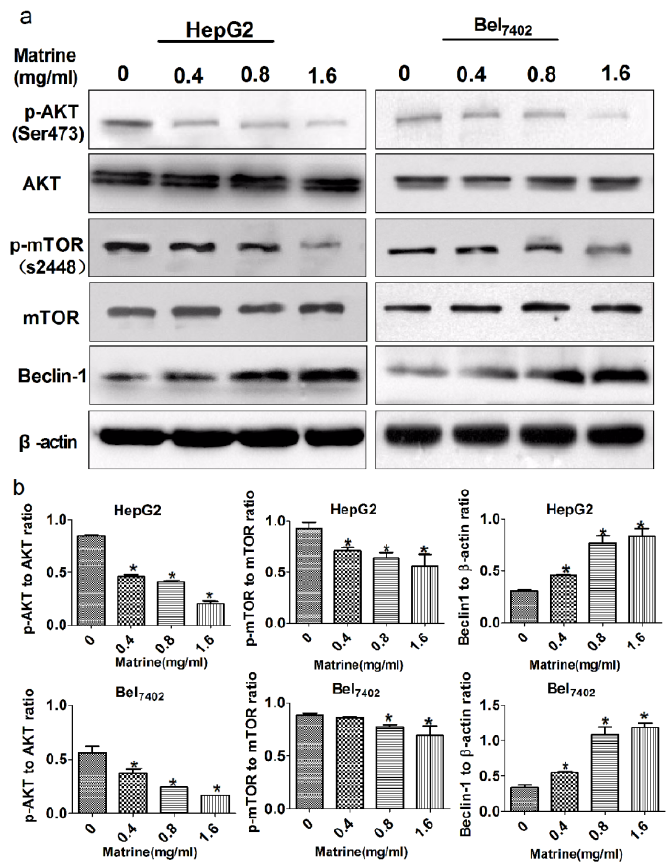
Figure 5. PI3K/AKT/mTOR signaling and beclin-1 are involved in matrine-induced autophagy. ( a ) Western blot analysis of pAKT, total AKT, p-mTOR, total mTOR, and beclin-1 in HepG2 and Bel cells. β -actin is shown as a loading control. Data are 7402 from three independent experiments; ( b ) Analysis of relative expression of pAKT,